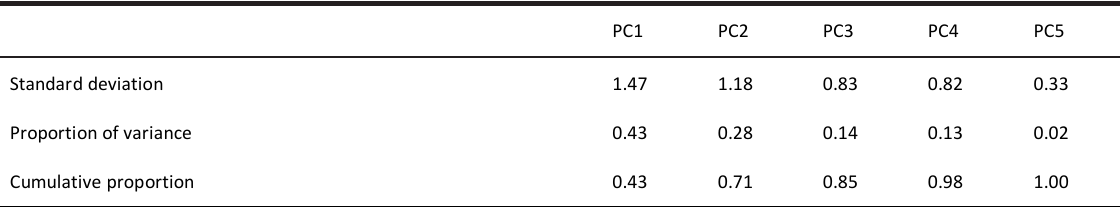
Table S5. Details of the five principal components. For each principal component we report its standard deviation, the proportion of variance explained and the cumulative proportion of this variance. In our linear regression we kept the first two principal components as their standard deviation is >1 (i.e. their eigenvalue >1) and combined they explain >70 % of